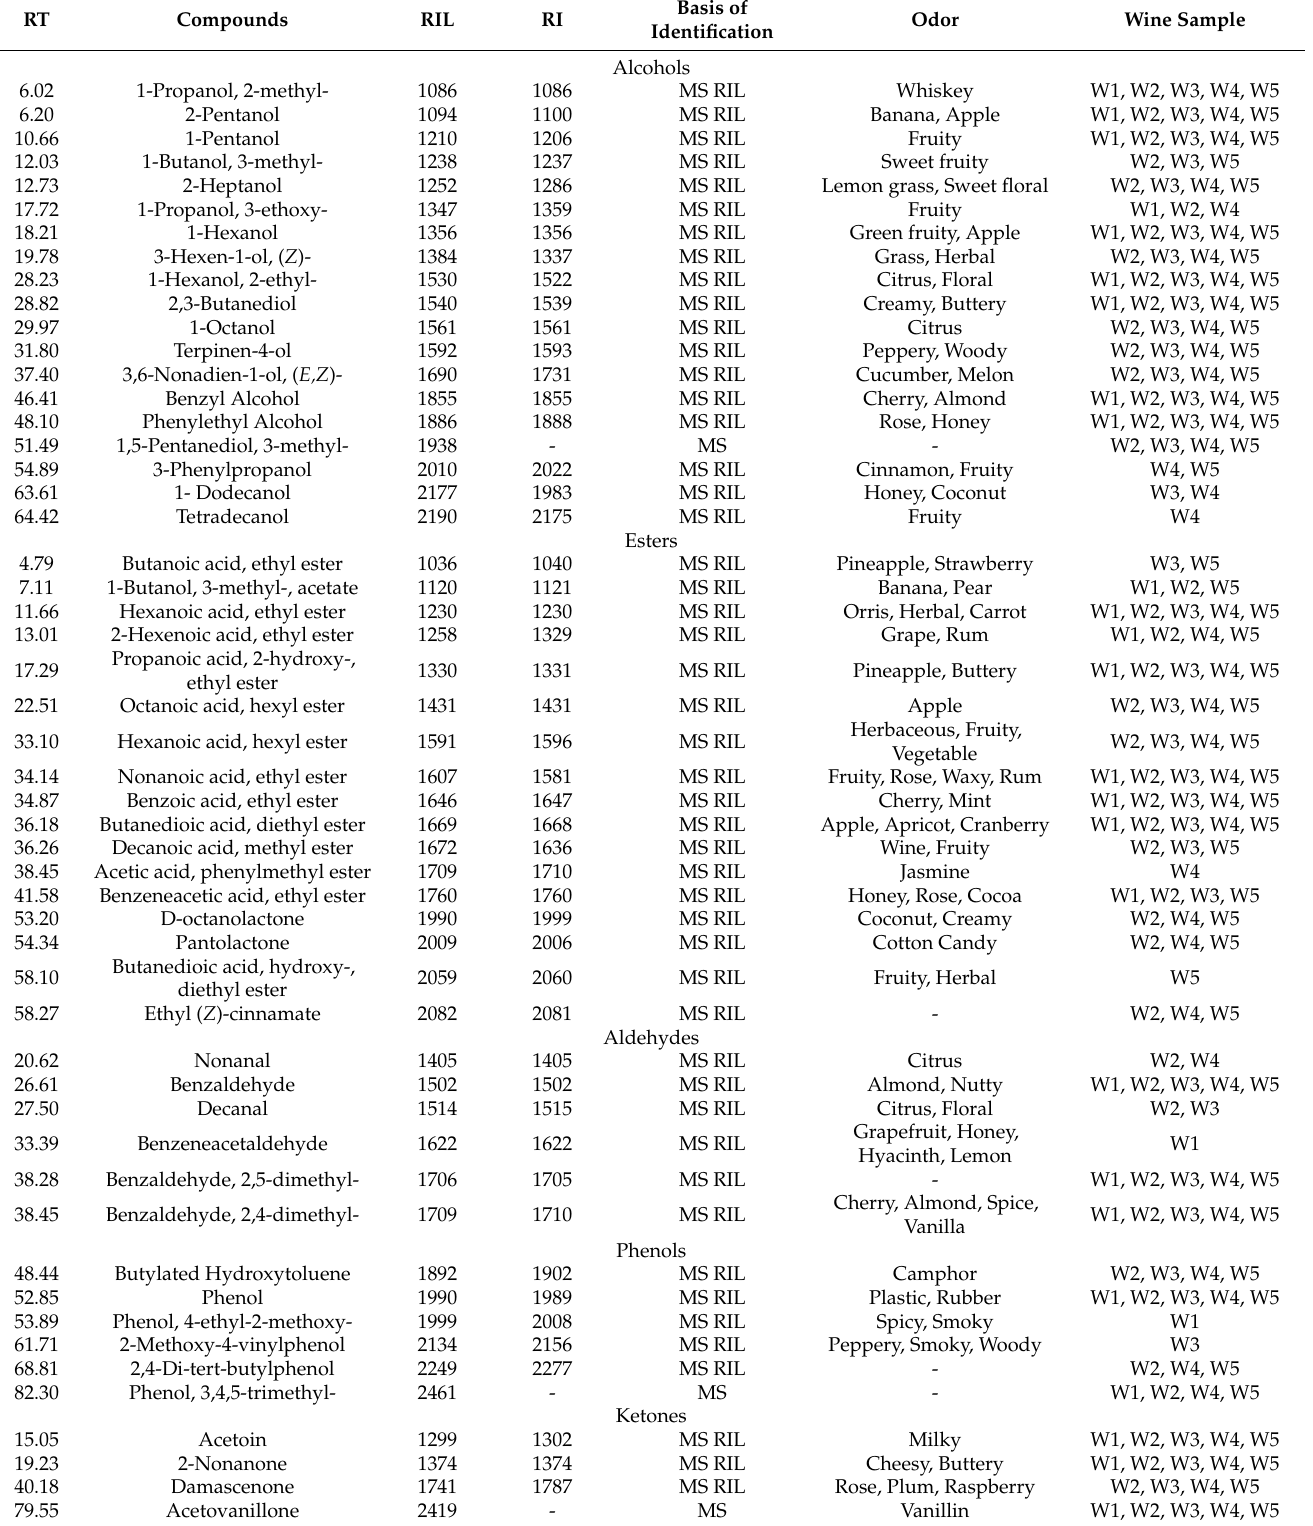
Table 5. Key volatile compounds identified in the black chokeberry wines made by different brewing